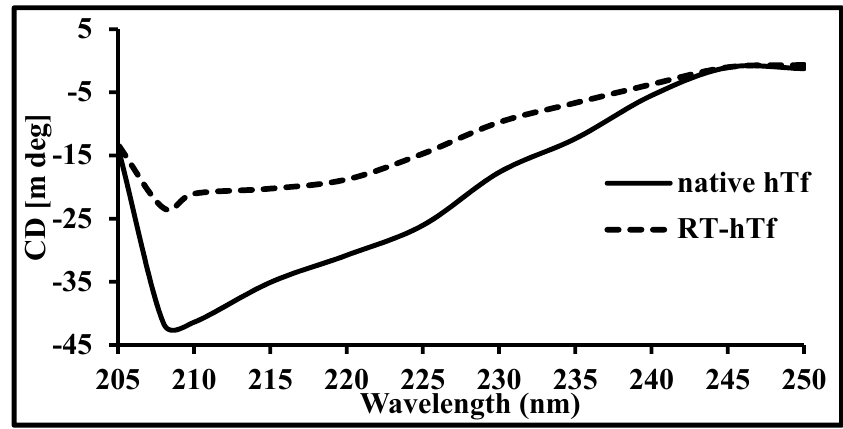
Figure 5. Far UV circular dichroism (CD) spectra of native hTf (—) and RT–hTf (1:8). The x -axis shows the wavelength range in which CD spectra is recorded while the y -axis shows CD in